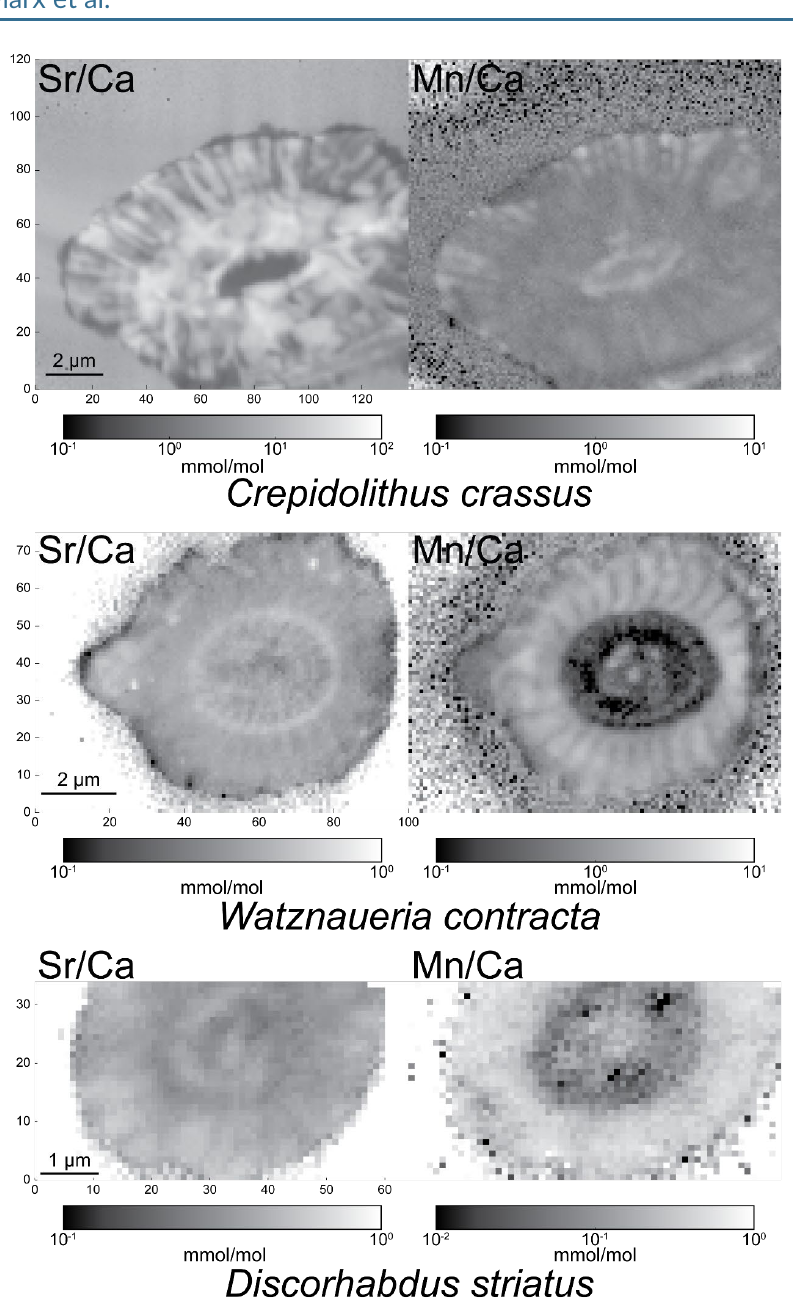
Figure 3. Mn/Ca and Sr/Ca (mmol/mol) maps of C. crassus , D. striatus and W. contracta